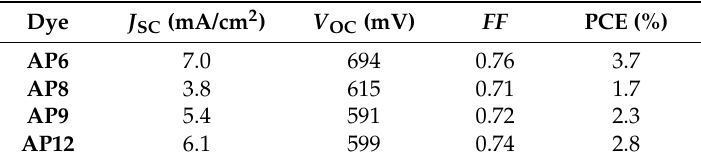
Table 2. Summary of photovoltaic parameters for AP dyes.